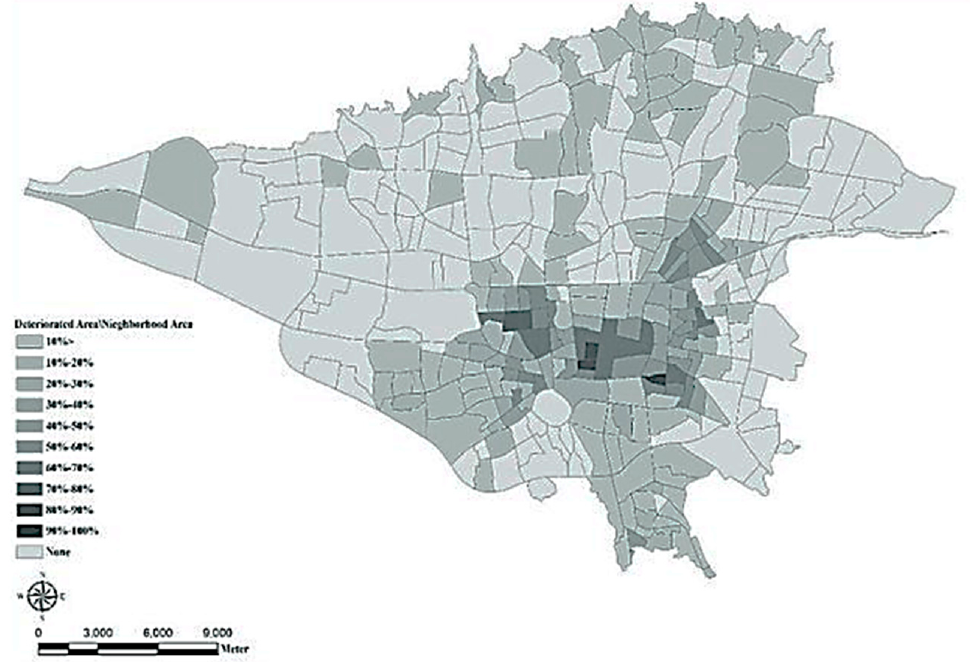
Figure 3. Map of the worn-out areas in Tehran (Courtesy of the Department of spatial data of UROT, 2021).